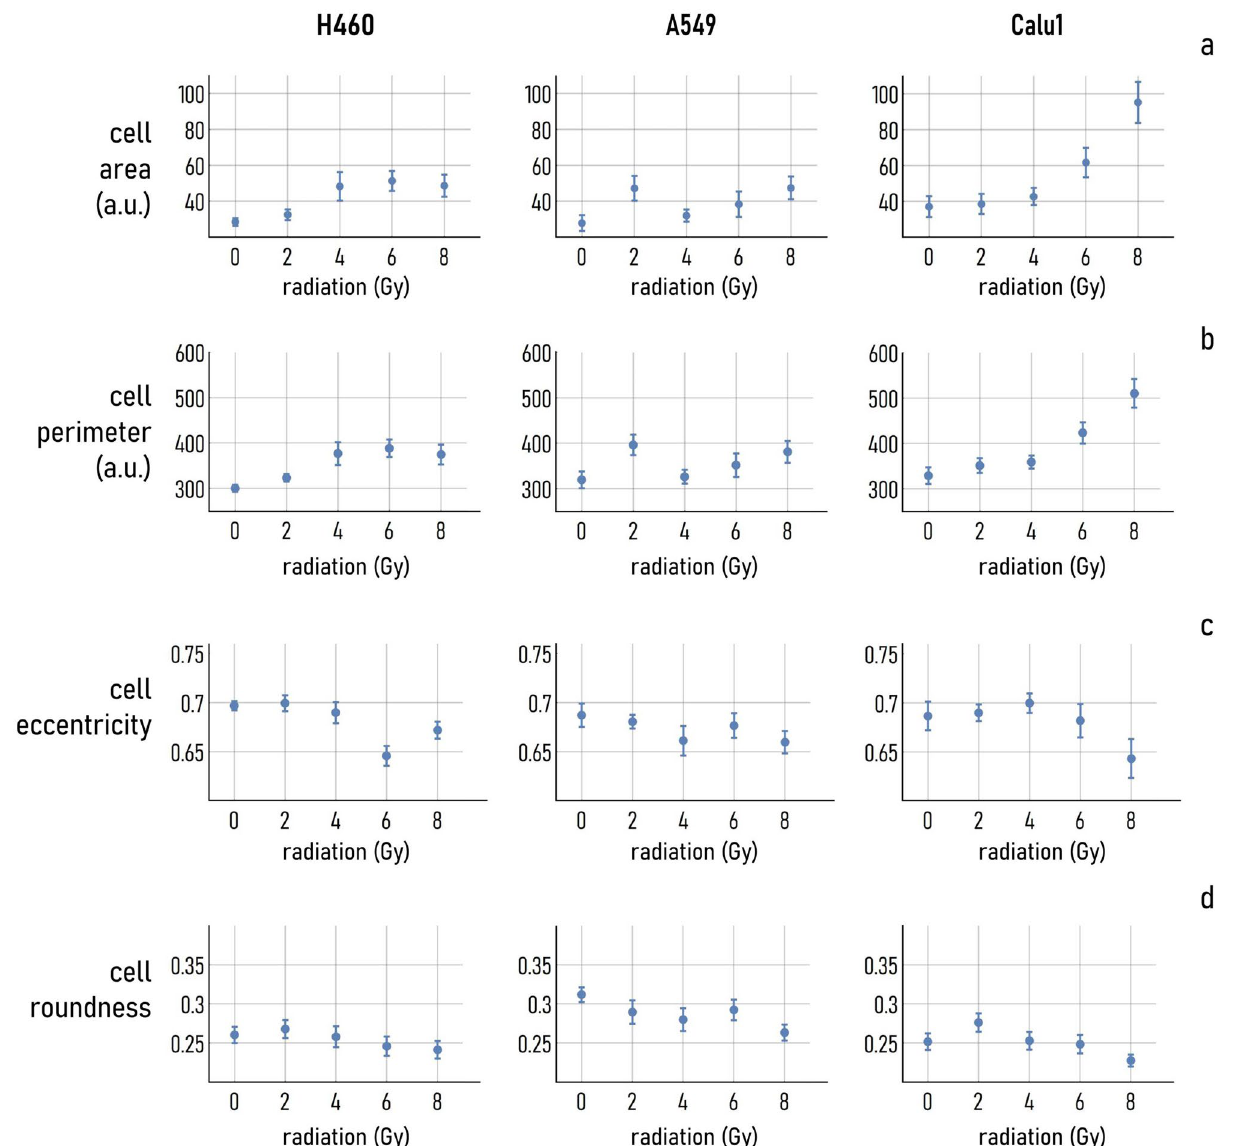
Figure 5. Cell morphological parameters extracted from the three cell lines (H460, A549, Calu-1) as a function of the external radiation in Gy. Specifically, we have determined the cell area ( a ), perimeter ( b ), eccentricity ( c ) and roundness ( d ) for the 0, 2, 4, 6, 8 Gy radiation